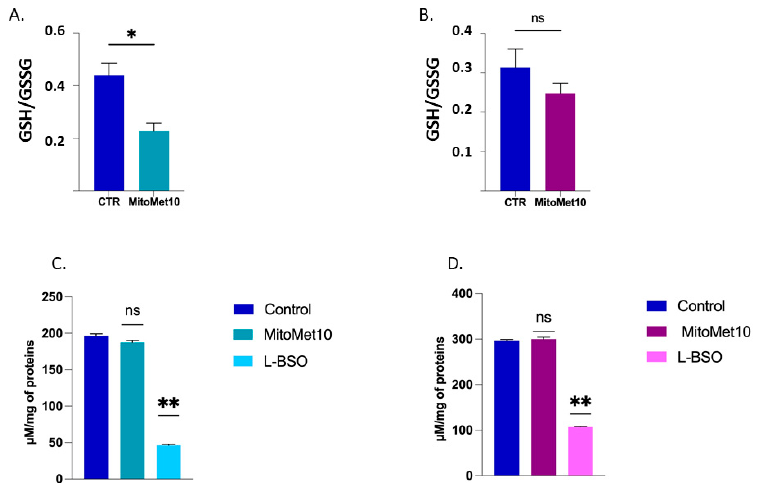
Figure 5. Impact of MM10 on glutathione levels in prostate cancer cells. ( A ) Impact on GSH/GSSG ratio of PC-3 cells after 24 h exposure to MM10 (1 µ M). ( B ) Impact on GSH/GSSG ratio of DU-145 cells after 24 h exposure to MM10 (1 µ M). ( C ) Impact on GSH tot level of PC3 cells after 24 h exposure to MM10 (1 µ M) or L-BSO (25 µ M). ( D ) Impact on GSH tot level of DU-145 cells after 24 h exposure to mito-metformin10 (1 µ M) or L-BSO (25 µ M). L-BSO is an inhibitor of glutathione biosynthesis used as positive control. Bars represent means ± SEM ( µ M/mg of proteins), (*) p < 0.05, (**) p < 0.01, (ns) non-significant, Student’s t test, N = 3.